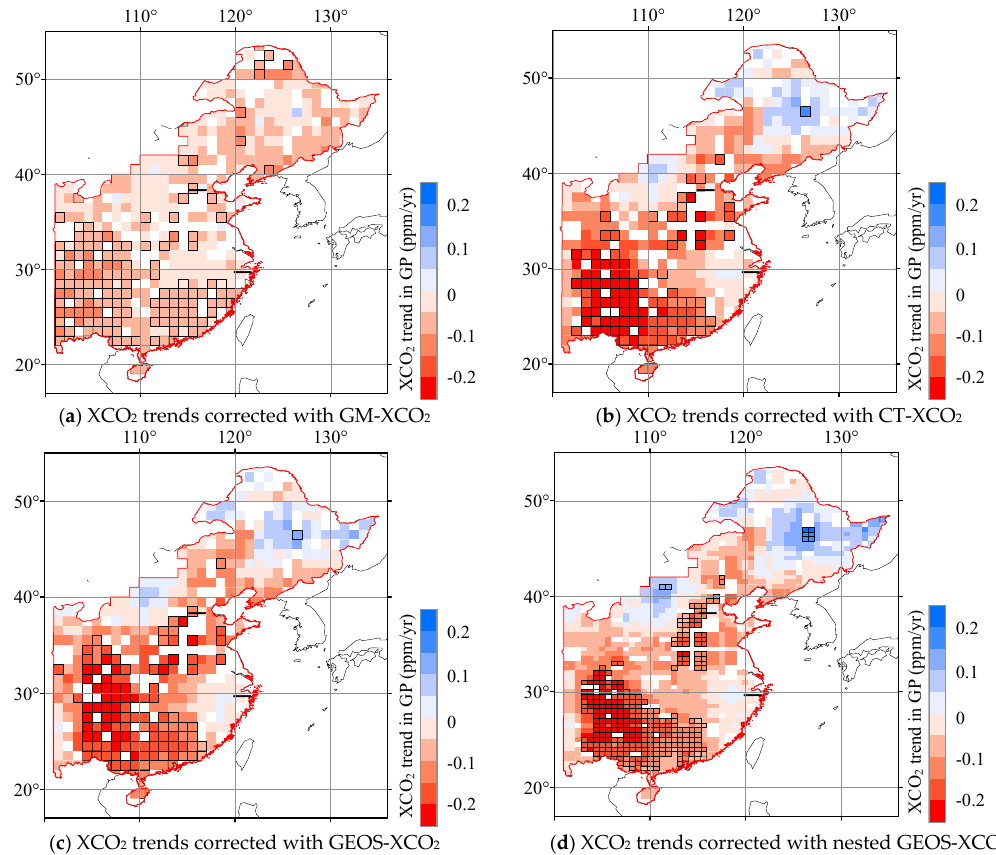
Figure 6. XCO 2 growing period drawdown trends from 2003 to 2015, after correcting GM-XCO 2 for remote background and local non-biospheric increases in XCO 2 by ( a ) removing the trend from GM-XCO 2 fitting, ( b ) CT-XCO 2 fitting, ( c ) background GEOS-XCO 2 , ( d ) and East Asia nested GEOS-XCO 2 . Red grid cells indicate decreasing trends, or stronger XCO2 drawdown during the GP and blue grids indicate increasing trends. Grid cells with black outlines in ( b ), ( c ), and ( d ) indicate significant trends within the grid cell (Mann–Kendal test, p < 0.05).